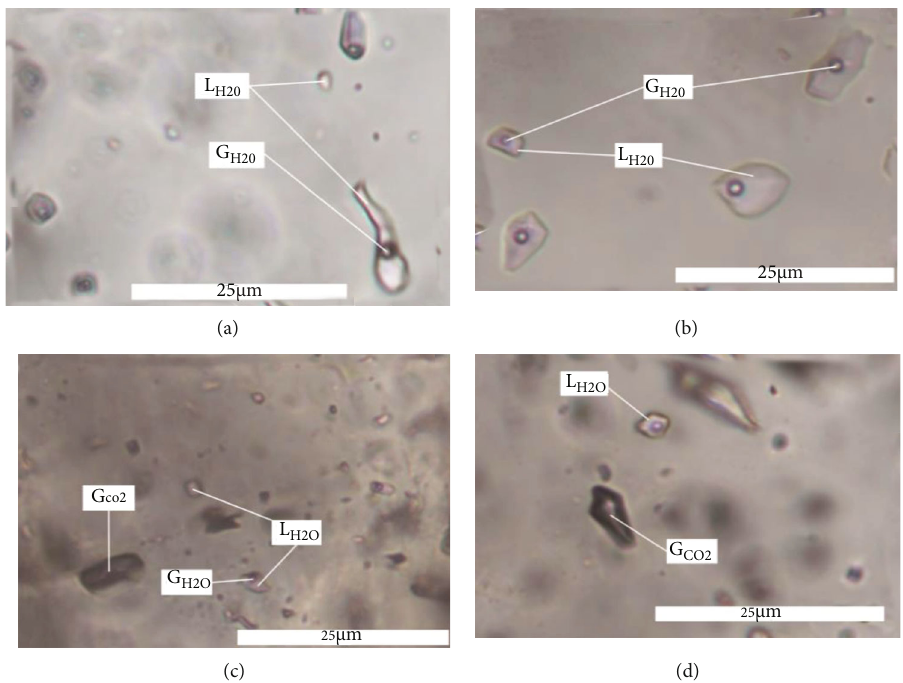
Figure 7: Photomicrographs of the typical fl uid inclusions of the Daping gold deposit. (a) Two-phase and liquid phase of the fi rst ore- forming stage. (b) Two-phase inclusions of the fi rst ore-forming stage. (c) Two-phase, liquid phase, and gas phase inclusions of the second ore-forming stage. (d) Two-phase and gas phase inclusions of the third ore-forming stage. Abbreviation: L H O; G CO : vapor CO vapor H 2 2 2